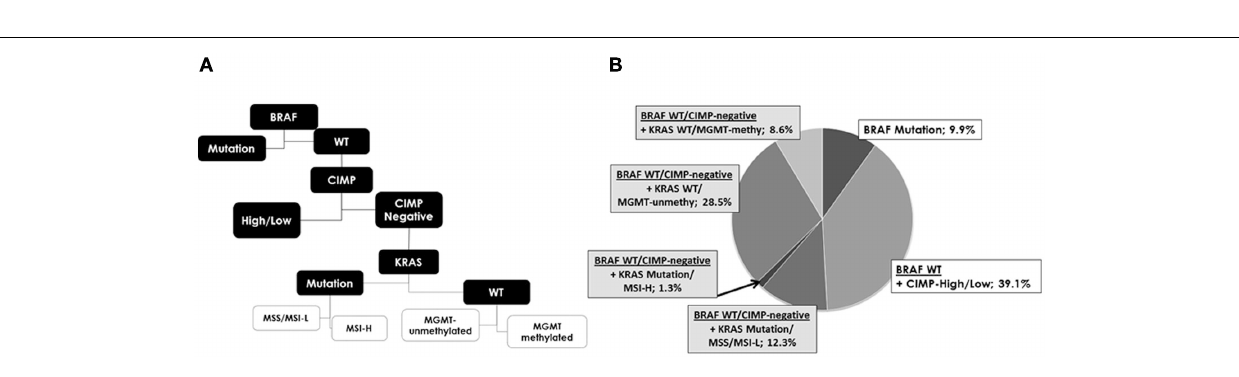
FIGURE 4 | (A) Analysis of the five molecular features using classification and regression tree analysis shows the hierarchy of most discriminating alterations and prognostic subgroups, namely subgroup 1: BRAF mutation,